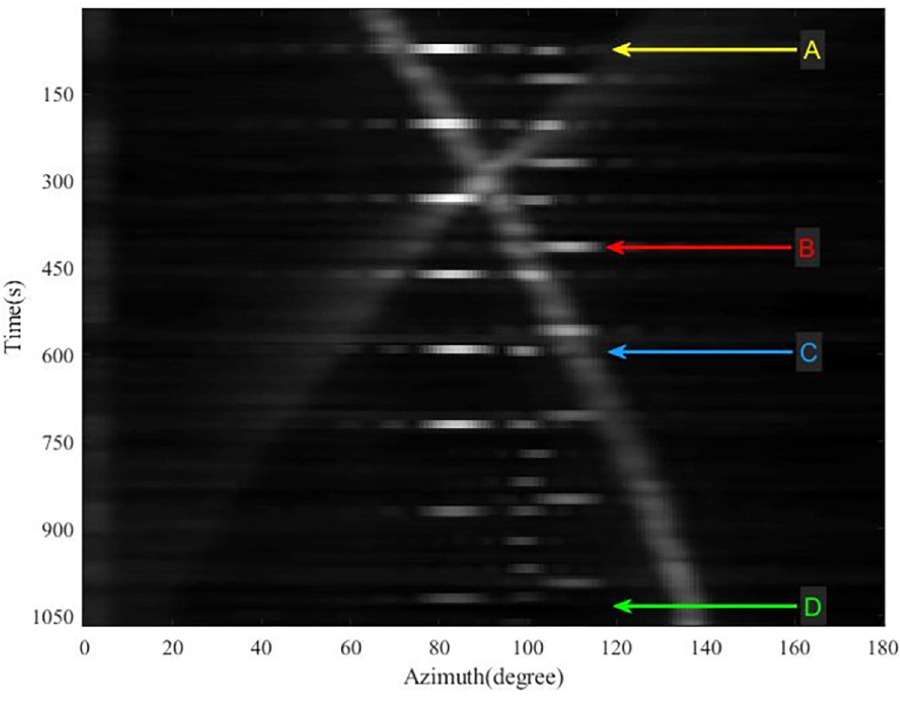
Fig 13. Time azimuth histogram of sea trial data obtained directly using beamforming.